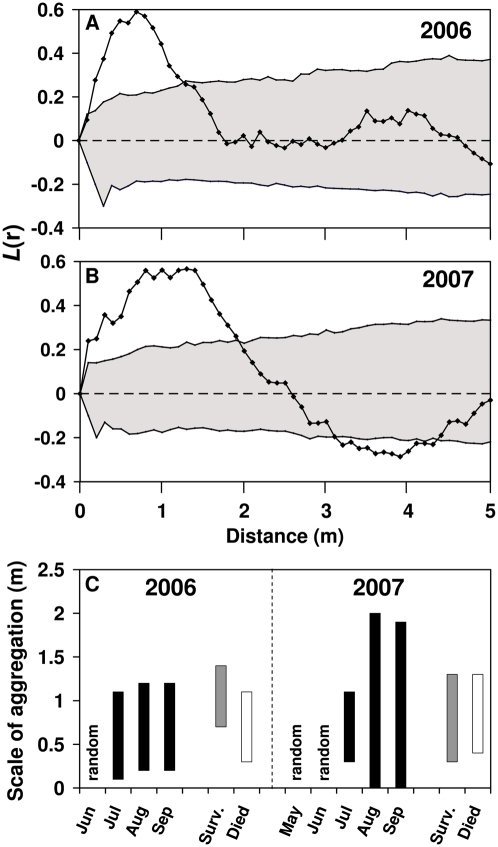
Spatial patterning of black-band disease (BBD).(A) and (B) Besag's L plots for all corals infected by BBD throughout the disease seasons of 2006 and 2007, respectively. The dashed line (L = 0) represents a spatially random (Poisson) distribution. Line with dots represents observed L values (Eq. 2) for infected corals. Shaded area represents the Monte Carlo 95% confidence interval (CI) envelope (see text). For distance scales (r) where L values fall within the envelope, the spatial distribution of infected corals does not differ significantly from the distribution of the susceptible corals as a whole. Infected corals are significantly aggregated (/over-dispersed) where the observed L values fall above (/below) the CI envelope. (C) Distance scales where the observed L values are above the range given by the 95% CI envelope. Black bars represent scale of aggregation of the accumulated corals infected by BBD for any month during the disease spread. Grey bars represent scale of aggregation for all surviving corals whose disease state was no longer evident (i.e., visible signs of BBD disappeared) at the end of the disease season. Finally, white bars represent scale of aggregation for all corals that died due to the disease by the end of the disease seasons.